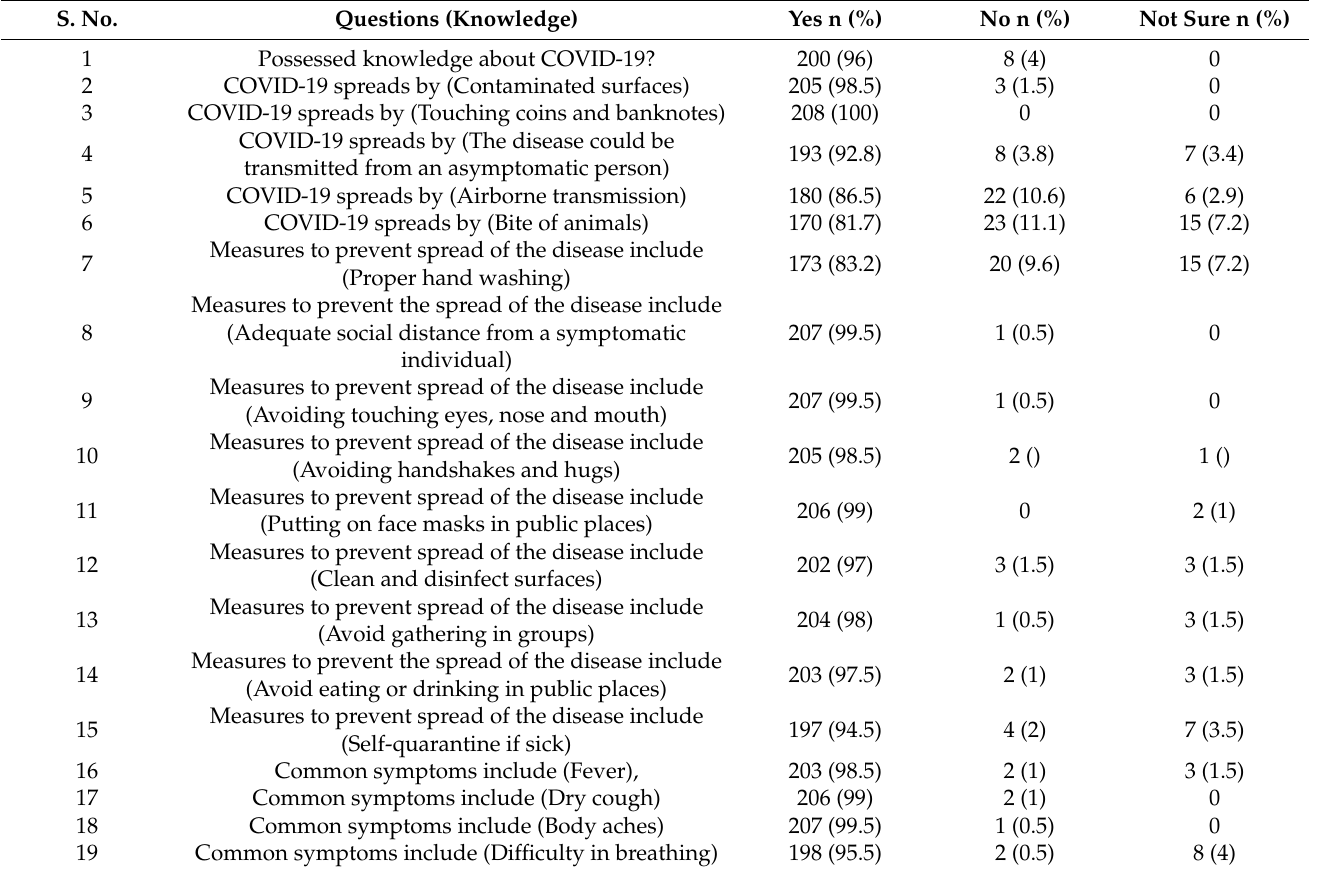
Table 2. Participant knowledge of COVID-19 (N =